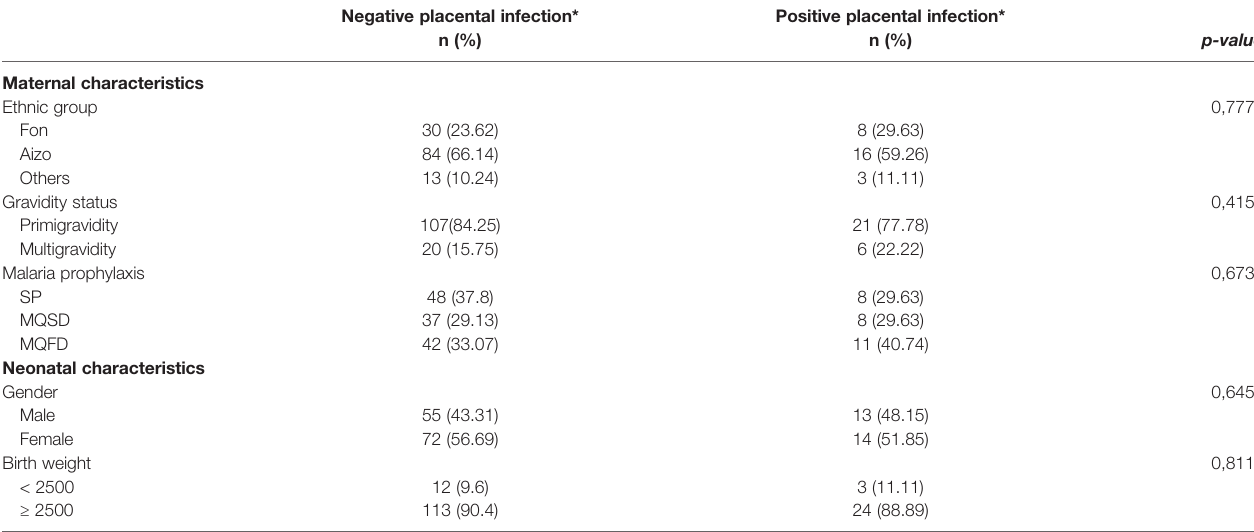
TABLE 1 | Characteristics of the population.